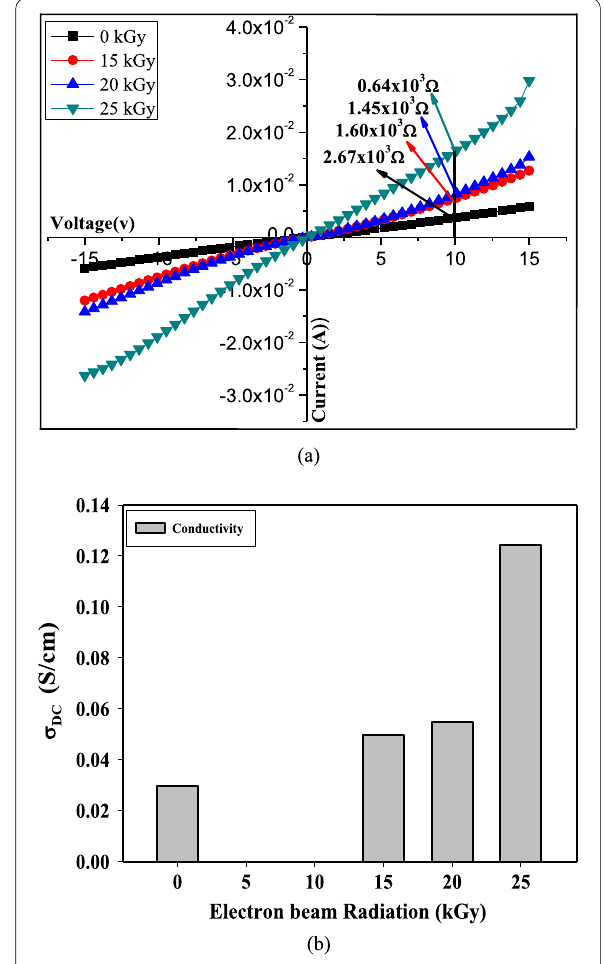
Fig. 4 a I–V curve of (XLPE/5‑ZnO) and b the curve shows the electrical conductivity of zinc oxide (ZnO) nanoparticles (NPs) obtained at different electron beam doses (i.e., 0, 15, 20, and 25